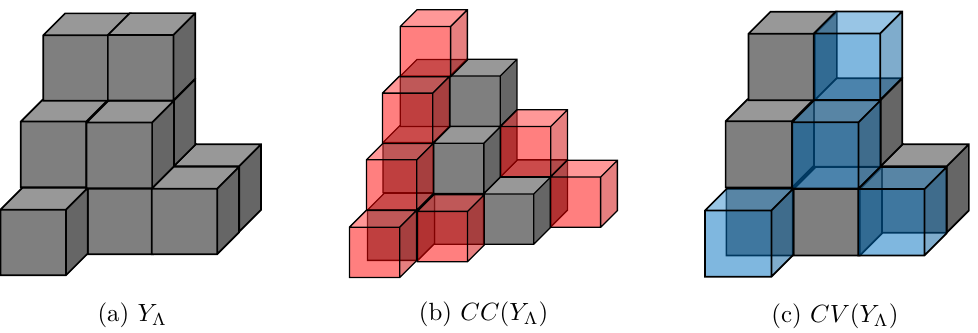
Figure 3. A configuration of the plane partition. (a) is the plane partition. (b) is the set of places where we can add boxes and (c) is the set of places where we can remove the